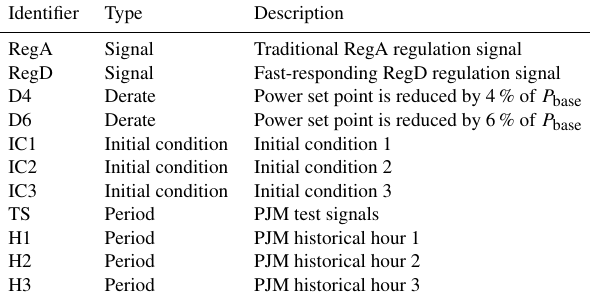
Table 1. Test case identifiers describing the signal type, derate amount, initial condition of the wind farm, and regulation signal period. For example, the test case “RegD.D6.IC1.H2” refers to the case with the second RegD historical signal, 6% derate, and the first initial